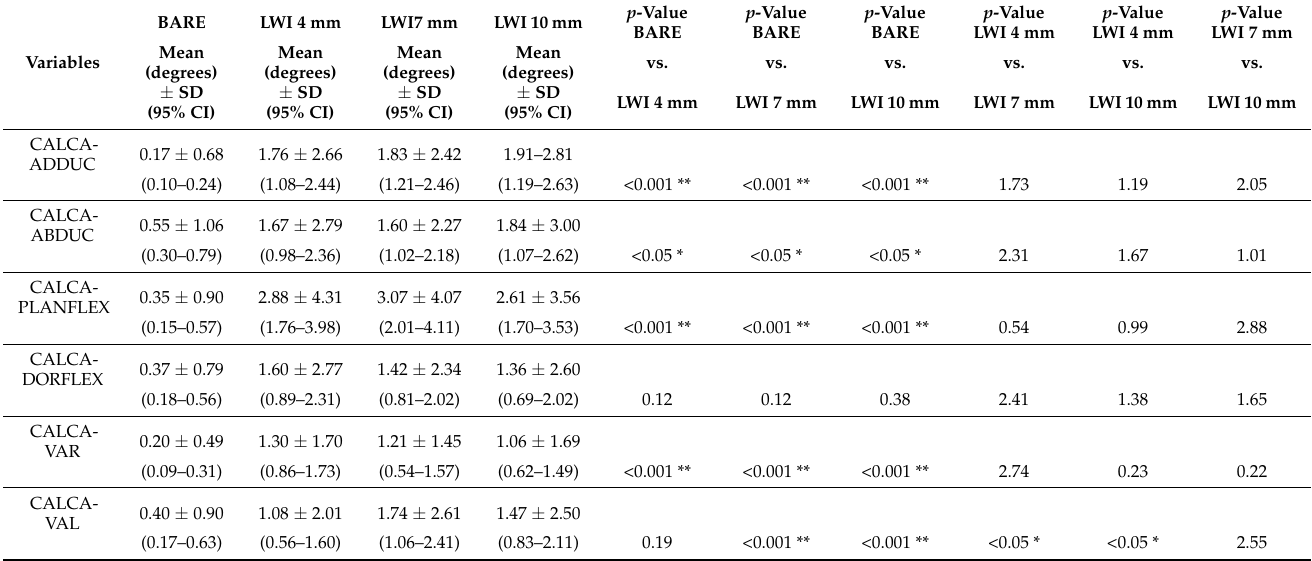
Table 6. The data of the calcaneus bone sensor movement under the four conditions.